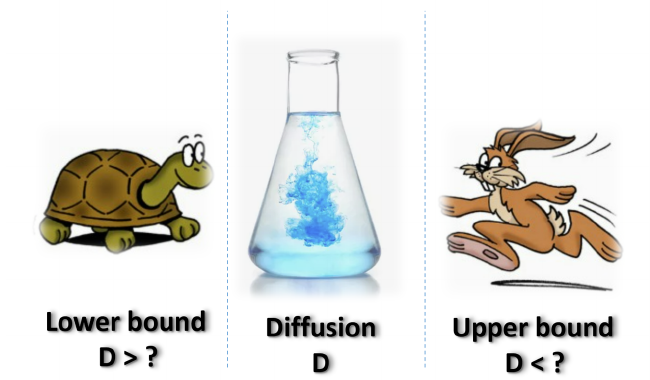
Figure 1 . Given an arbitrary diffusive process and its related diffusion constant D , does D obey any universal lower/upper bounds and in terms of which physical quantities? This is the question we address in this